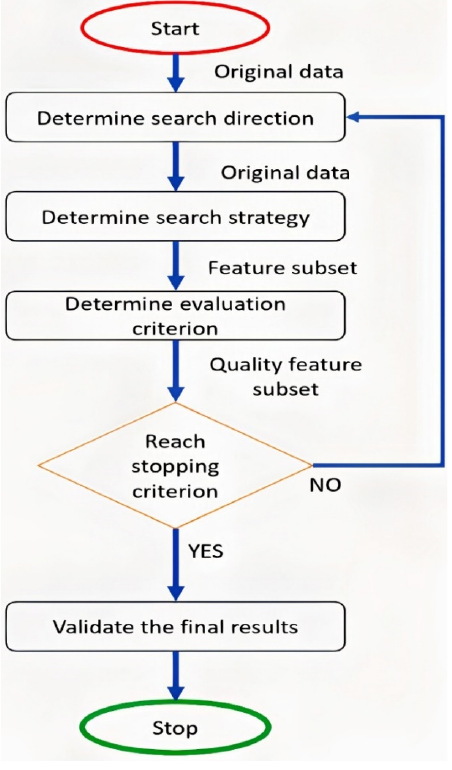
Figure 3. The basic steps of the feature selection process.